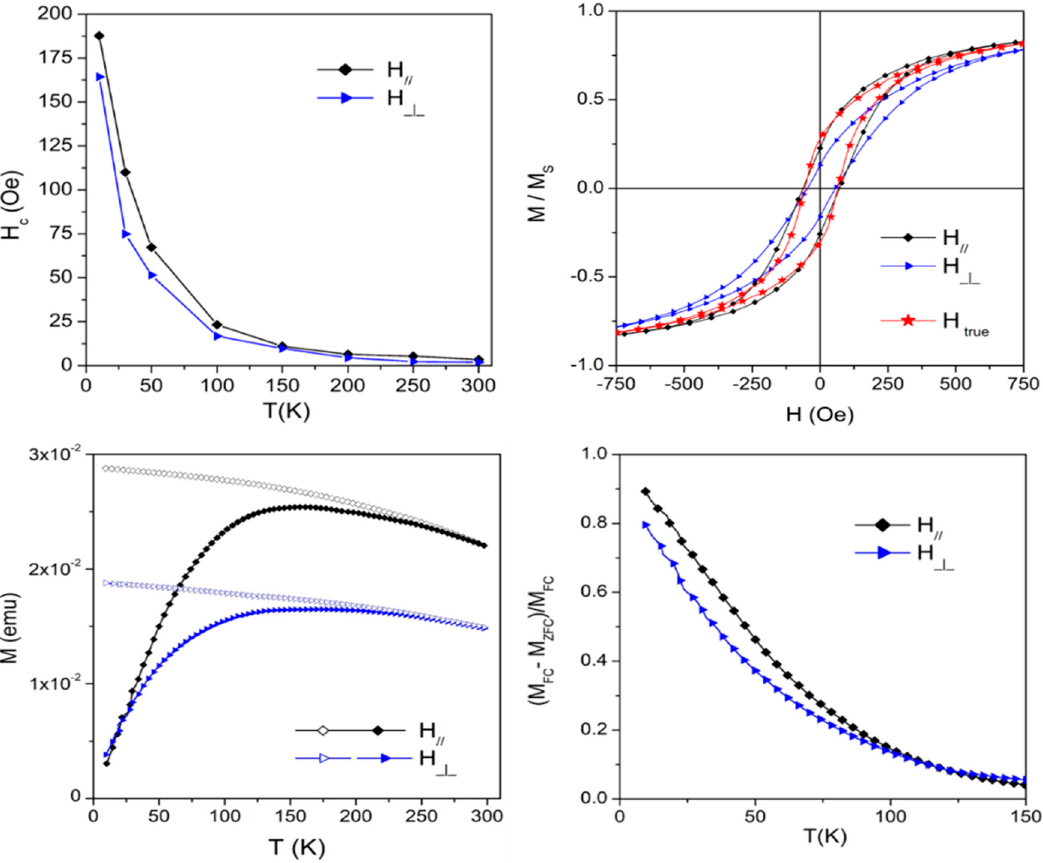
Figure 6. ( Top left ): anisotropic coercive field as a function of temperature; ( top right ): hysteresis loops measured at T = 50 K. The loops are different when plotted vs. the applied field; they become coincident when plotted vs. the true field; ( bottom left ): anisotropic FC/ZFC curves (applied field: 100 Oe); ( bottom right ): reduced FC-ZFC curve differences in parallel and perpendicular field configurations.